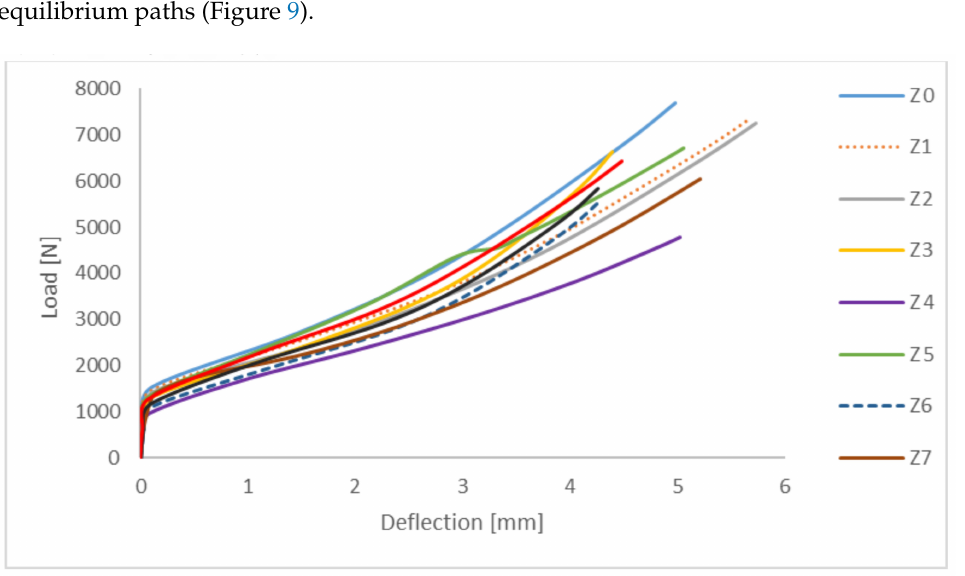
Figure 9. Post-critical equilibrium paths for a Z-section column using different